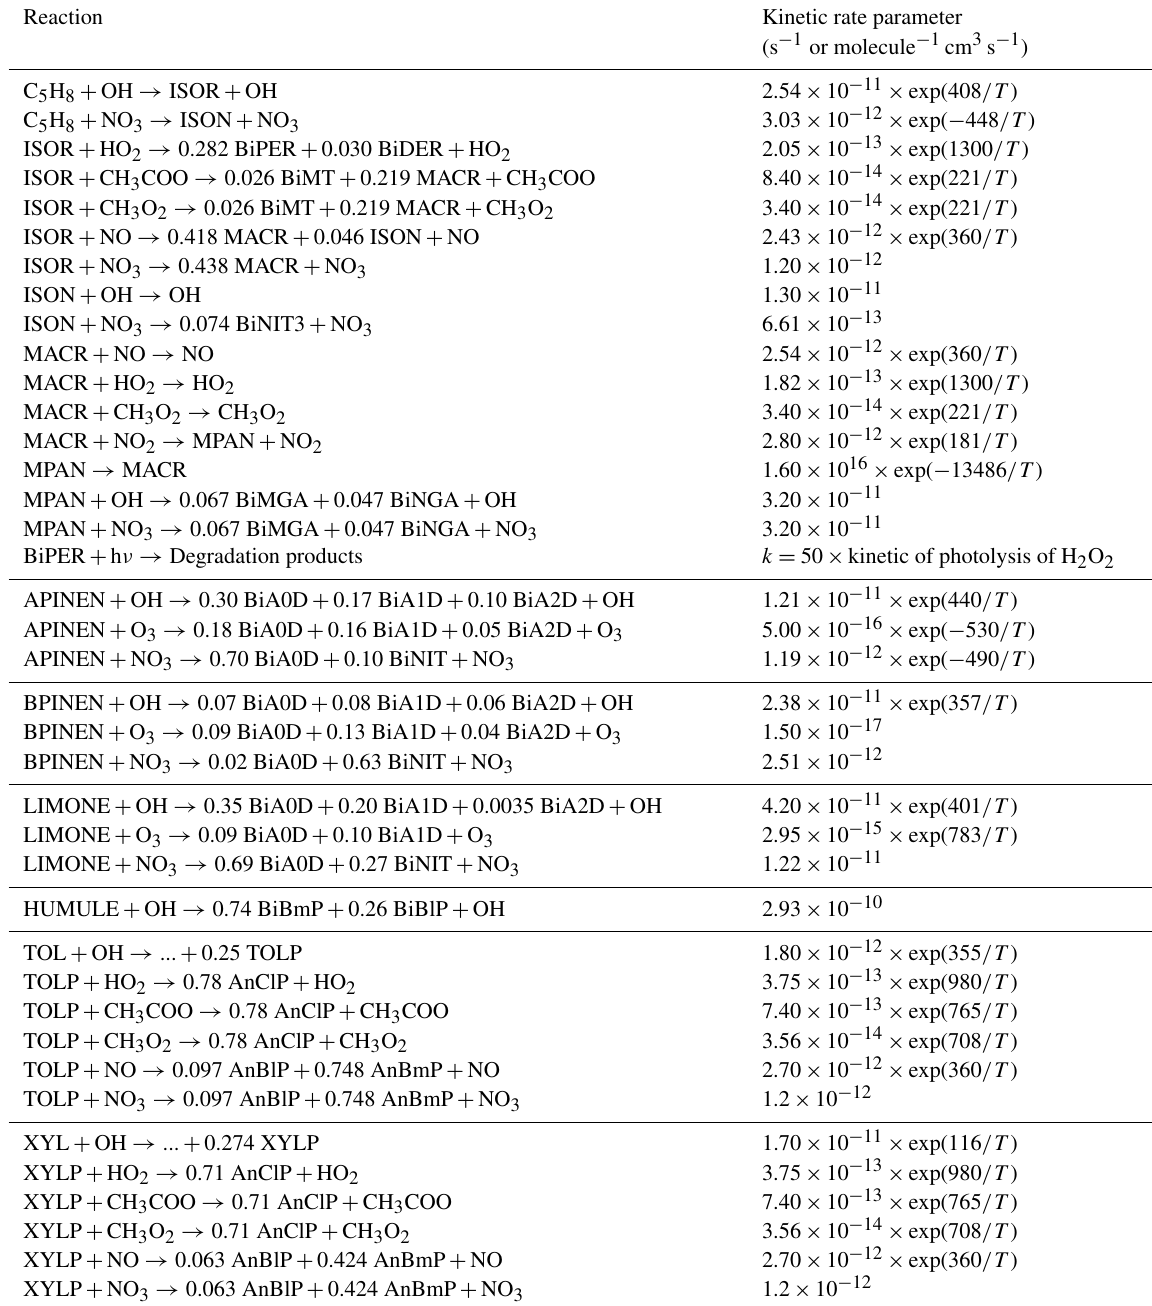
Table 1. Reactions leading to SOA formation a . C 5 H 8 refers to isoprene, APINEN to α -pinene, BPINEN to β -pinene, LIMONE to limonene, HUMULE to sesquiterpenes, TOL to toluene, XYL to